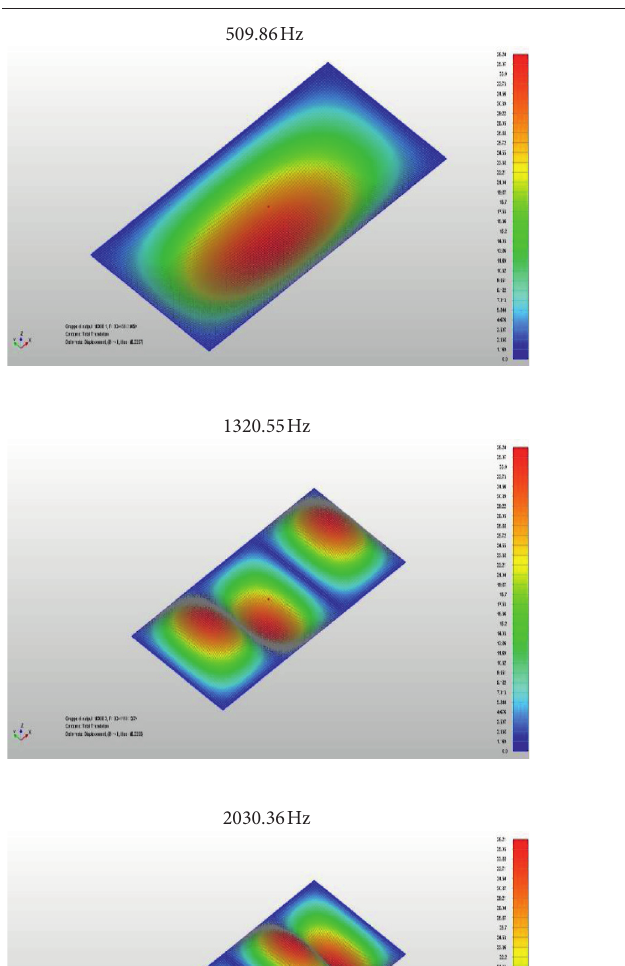
Figure 12: Numerical simulation: mesh and simply supported edges. Table 12: FEM simulation: mode shapes and natural frequencies (Case